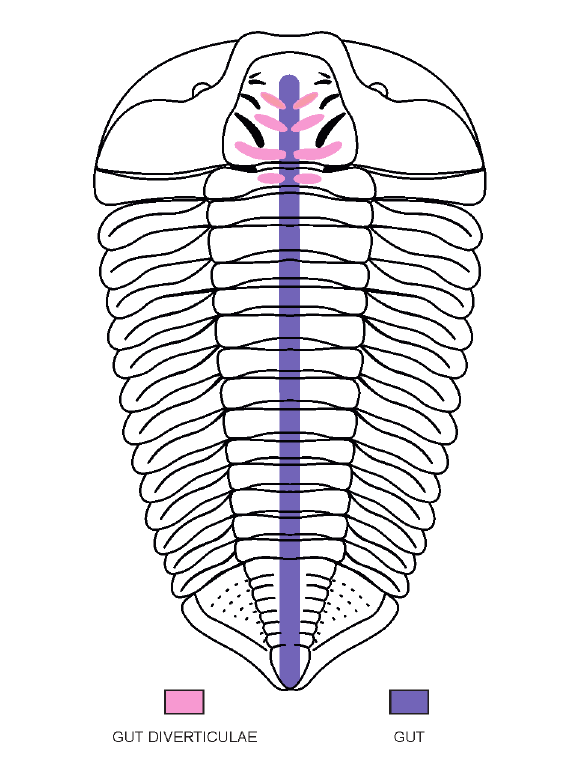
Fig. 6. Reconstruction of the morphology of the preserved parts of the digestive system in the cephalic, thoracic and pygidial regions of Colpocoryphe in dorsal